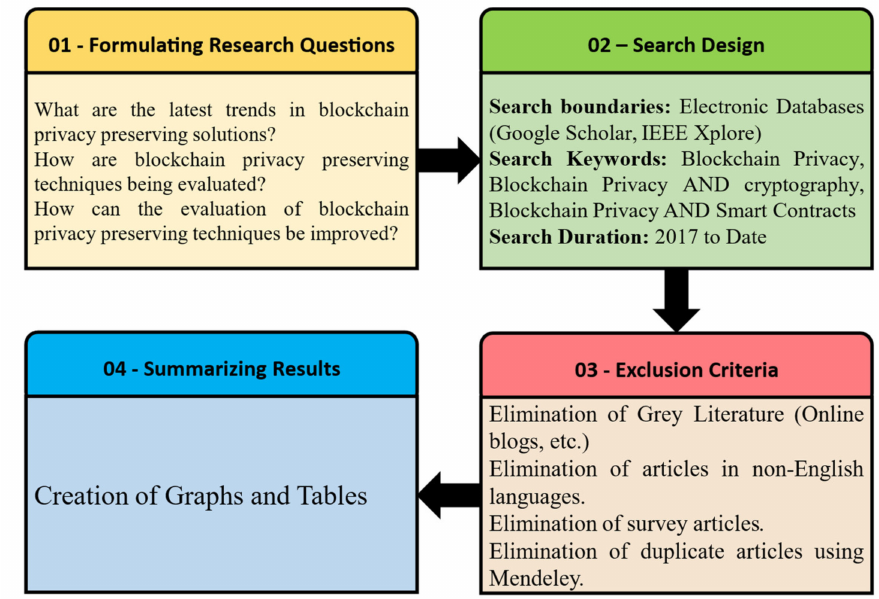
Figure 4. Survey methodology.